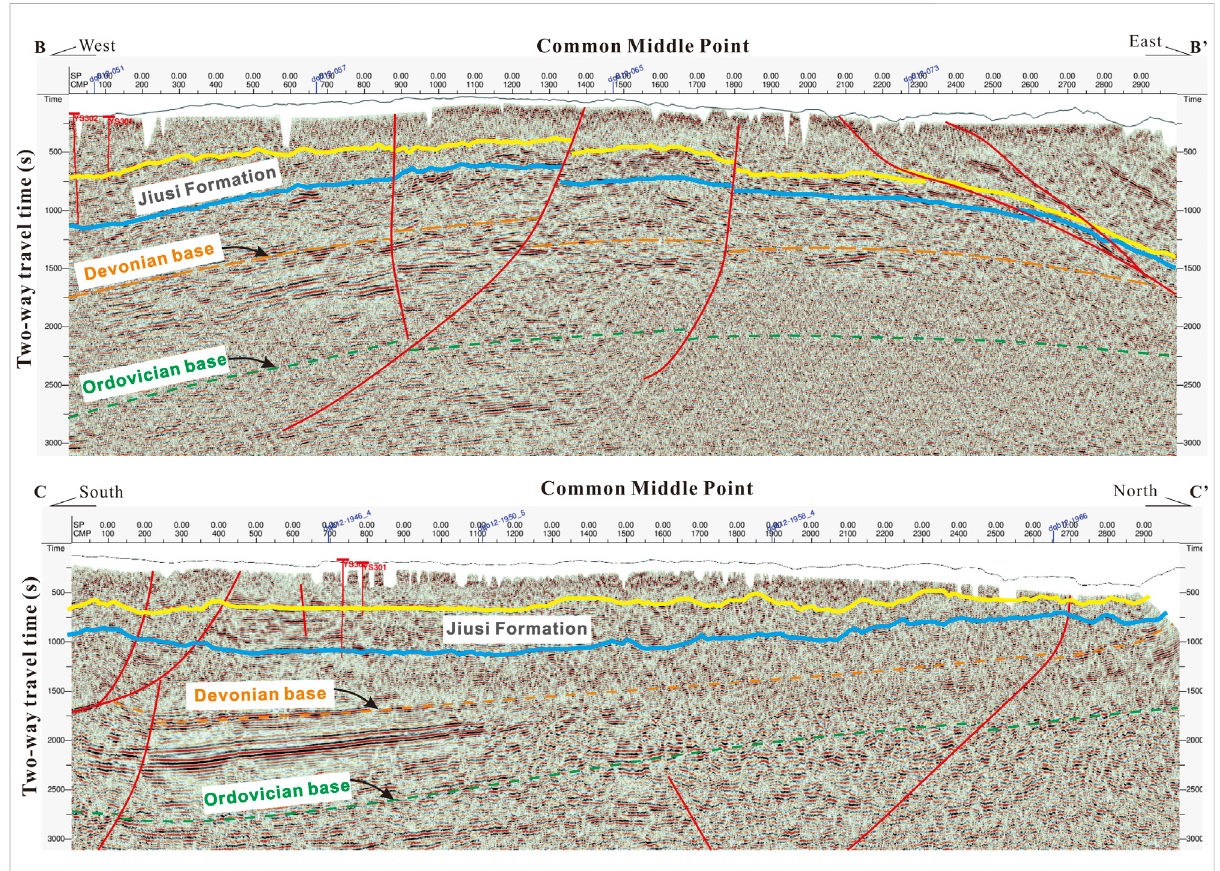
FIGURE 3 Interpreted seismic pro fi les, including the YS302 well (pro fi le locations shown in Figure 4A). (B-B ’ ) West-East direction of the seismic pro fi le cross the YS302 well. (C-C ’ ) South-North direction of the seismic pro fi le cross the YS302 well.